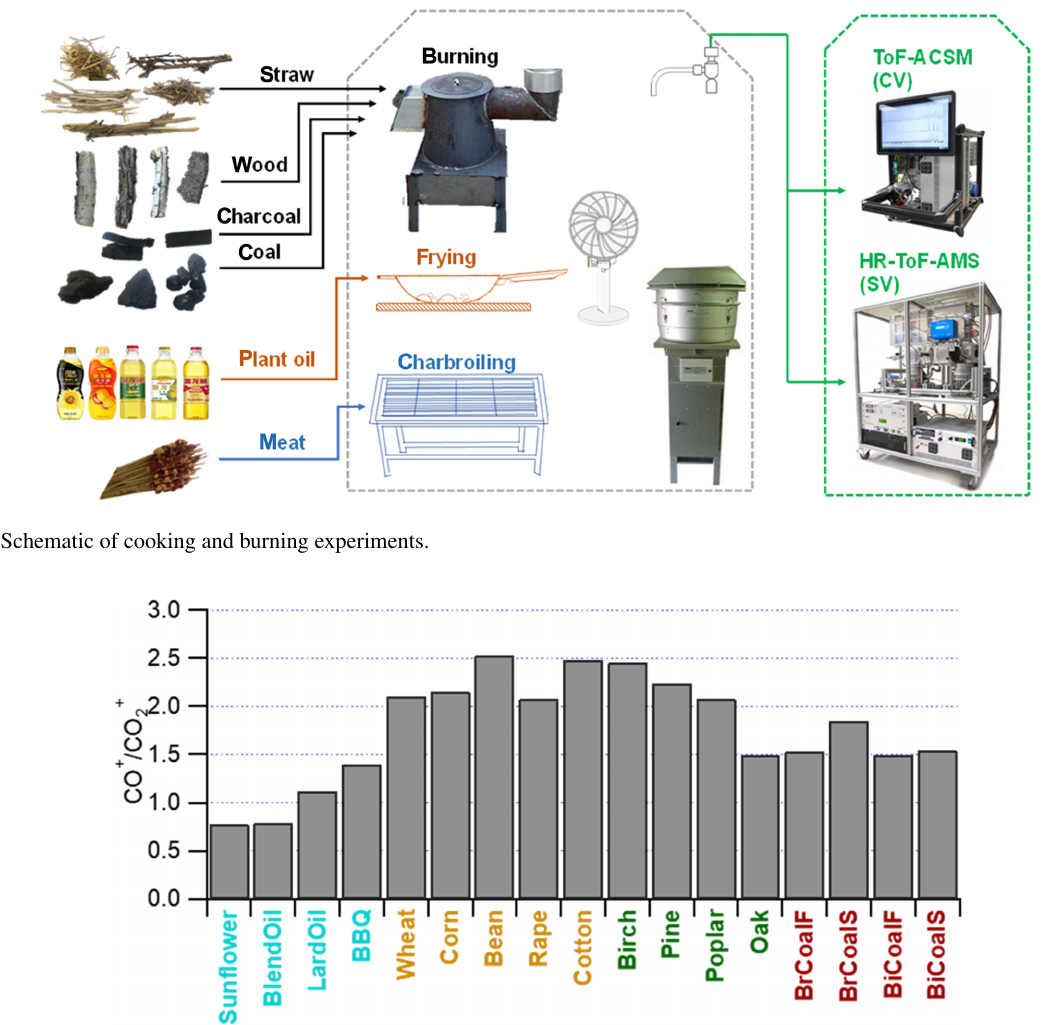
for WSOA from 17 cooking and burning experiments. 2